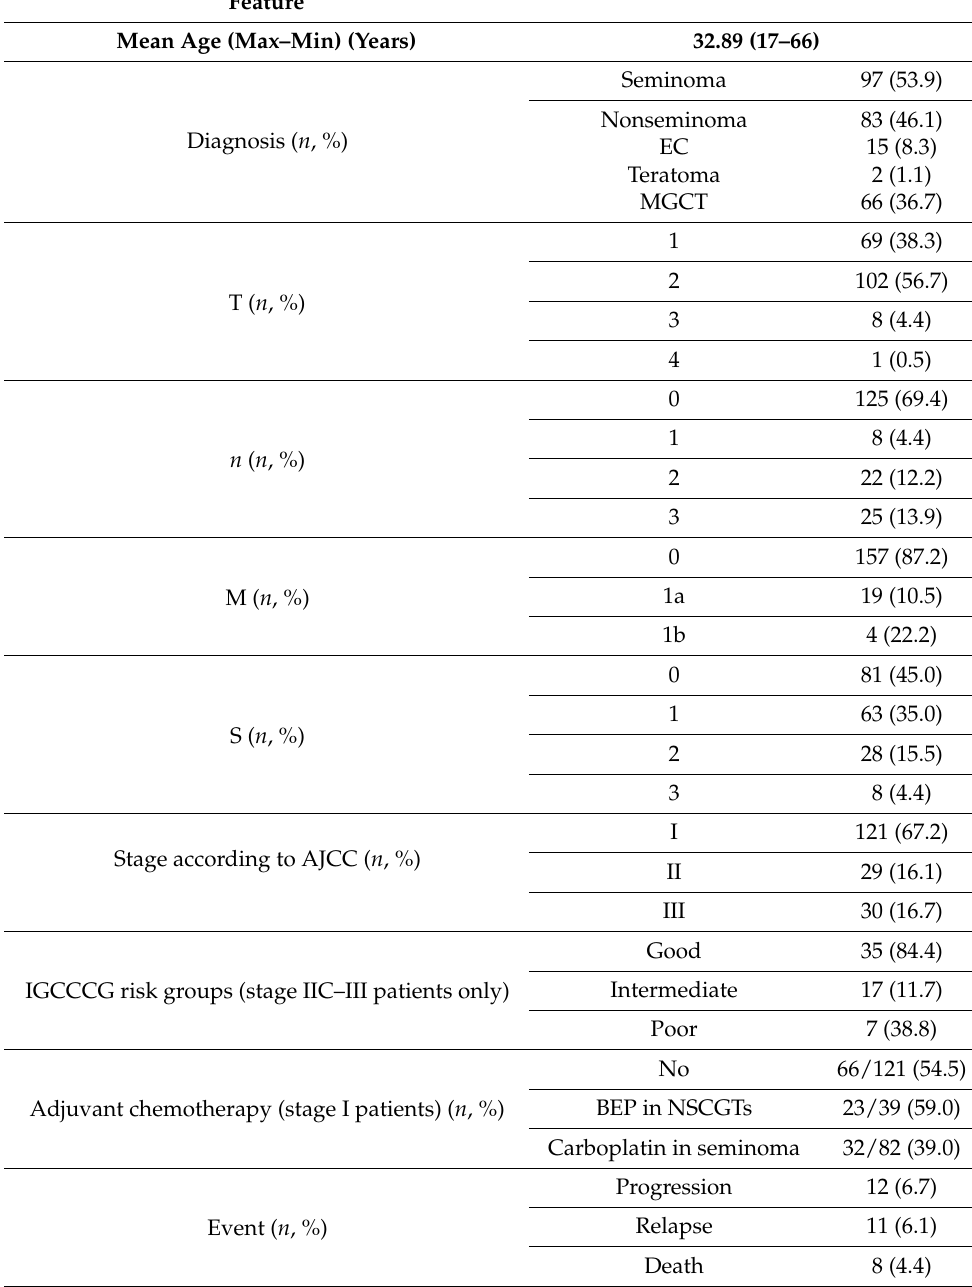
Table 1. Basic characteristics of the study group. Abbreviations: EC—embryonal carcinoma; MGCT— mixed germ cell tumor; BEP—Bleomycin, etoposide and cisplatinum; PD-L1—Programmed death- ligand 1; VISTA—V-domain immunoglobulin suppressor of T cell activation; IGCCCG—International Germ Cell Cancer Collaborative